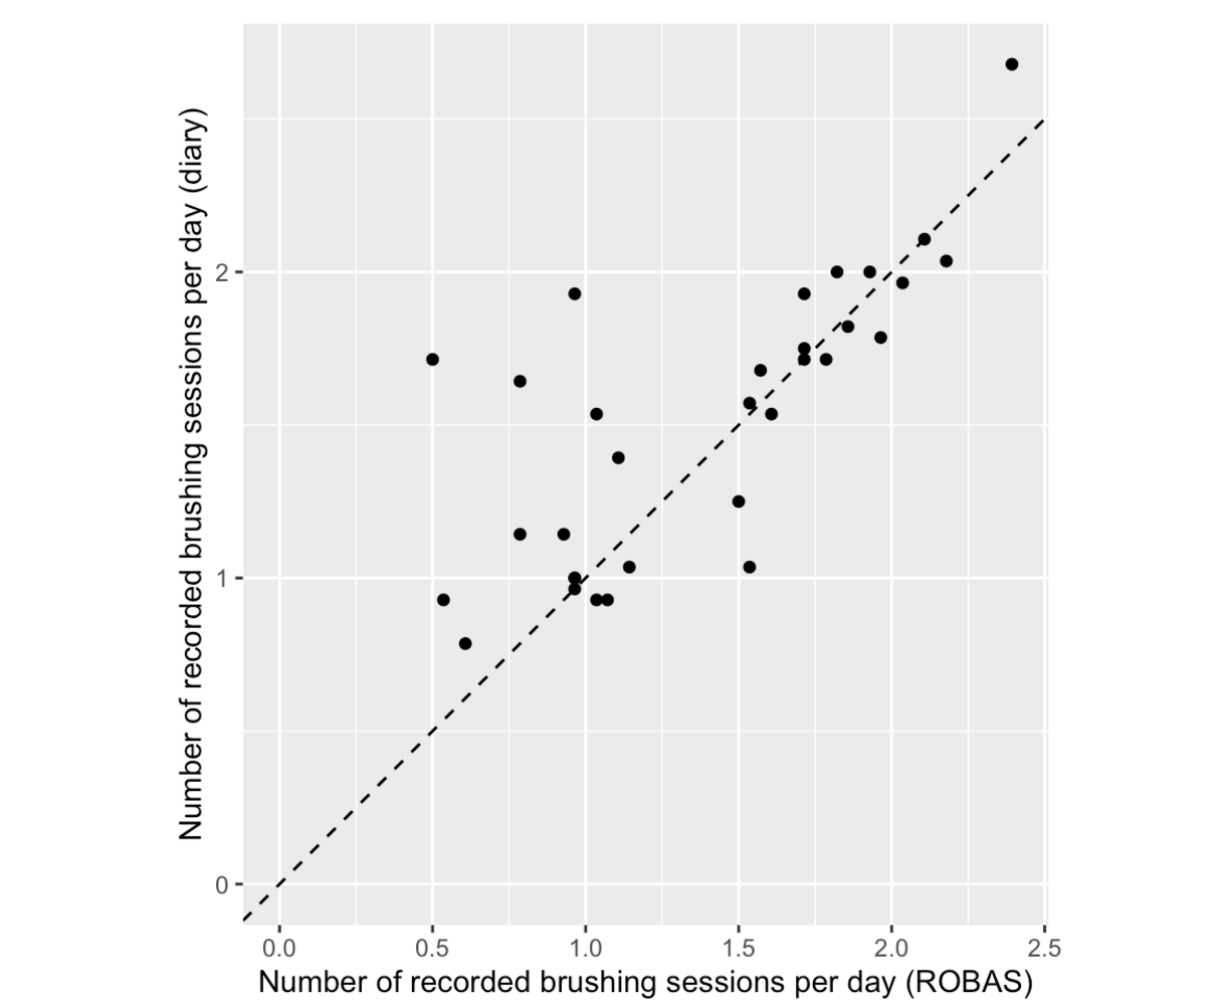
Figure 2. Brushing sessions recorded in participant diaries and by ROBAS. Dashed line denotes y=x. ROBAS: Remote Oral Behaviors Assessment